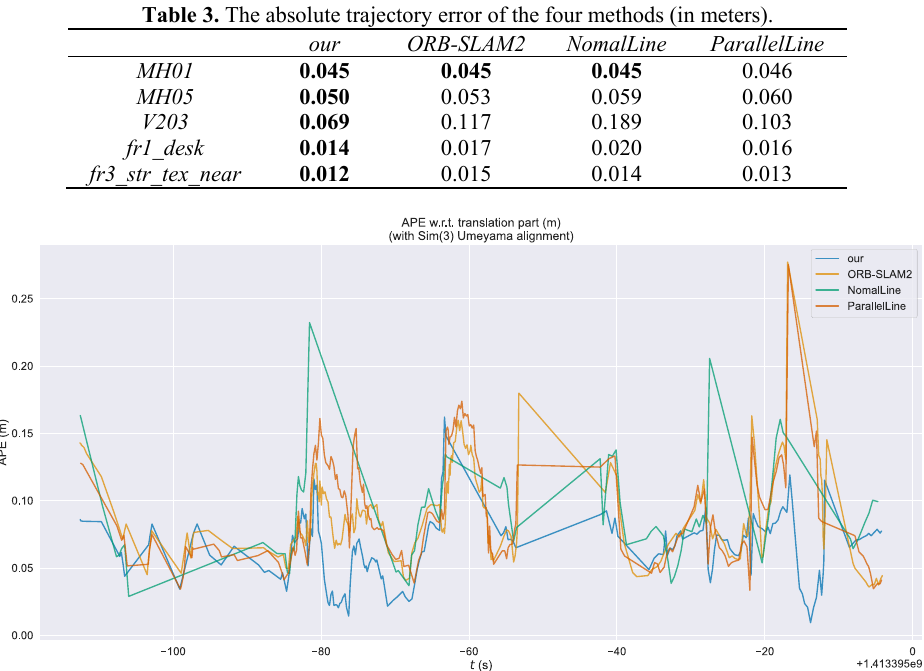
Figure 12. The plot of absolute trajectory error with